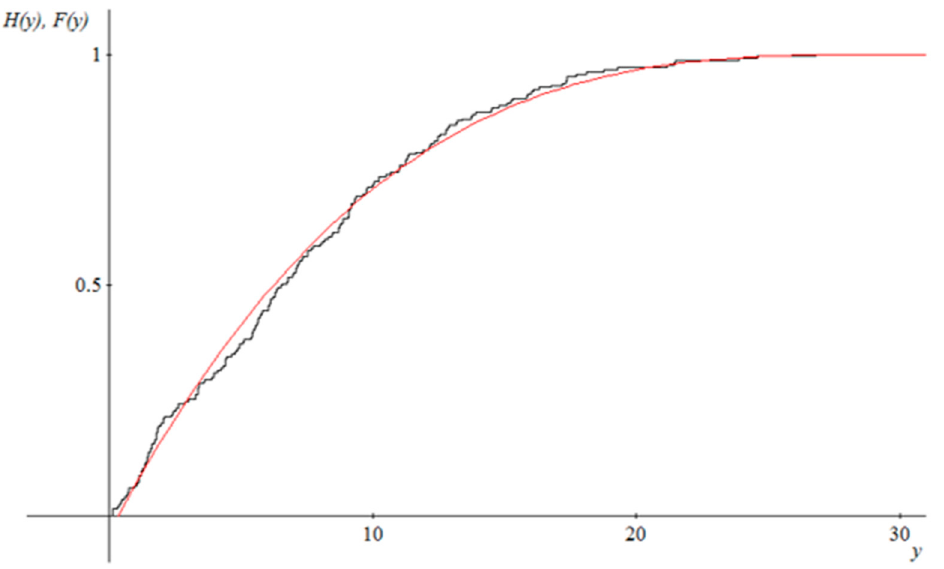
Figure 1. Graph showing the empirical cumulative distribution (black) ˆ F ( y 1 ) and fitting the theoreti- cal cumulative distribution H γ , µ , σ ( y 1 ) (red).